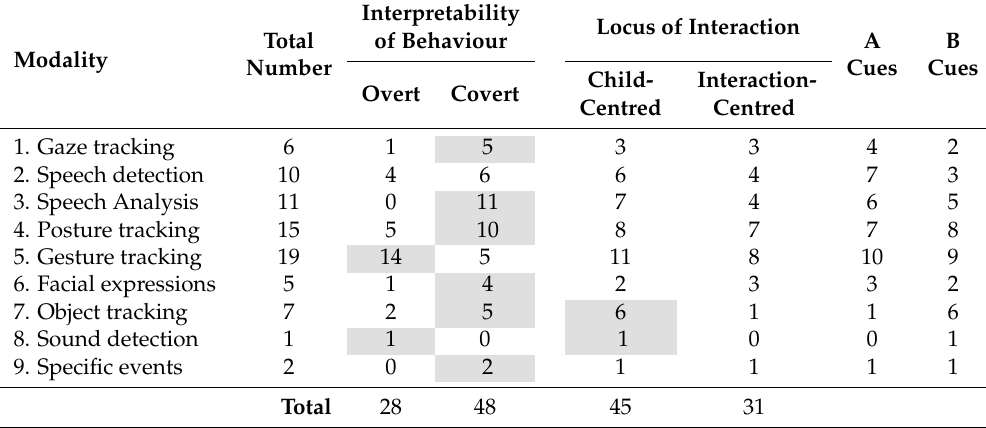
Table 3. The number of times the behaviour modalities are identified in the behavioural cues listed in Tables 1 and 2, split according to whether the behavioural cues can be considered Overt or Covert and Child-Centred or Interaction-Centred. Highlighted (in grey) cells indicate where either overt/covert or child-centred/interaction-centred are more than double its counterpart. This is on the understanding (see text) that covert cues are more difficult to automatically characterise than overt cues, and that interaction-centred cues are more (practically) difficult to assess than child-centred